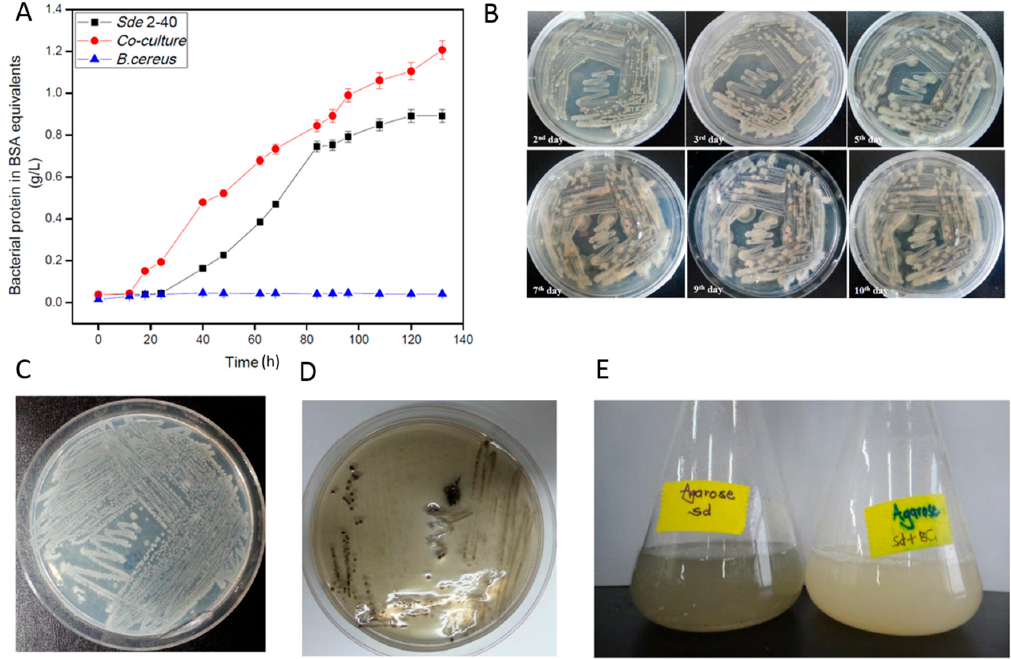
Figure 2. Characteristics of Sde 2-40 and B. cereus. ( A ) Growth profiles of Sde 2-40, B. cereus , and co-culture on 1% ( w / v ) agarose; ( B ) Sde 2-40 growing on sea salt minimal media agar plate along with B. cereus . Increase in pit size with increasing time is indicated by arrows; ( C ) Growth characteristics of B. cereus on minimal sea salt agar media; ( D ) Growth characteristics of Sde 2-40 where agar pitting colonies were turned black; ( E ) Pure culture of Sde 2-40 produced melanin while Sde 2-40 growing in co-culture with B. cereus did not produce melanin.